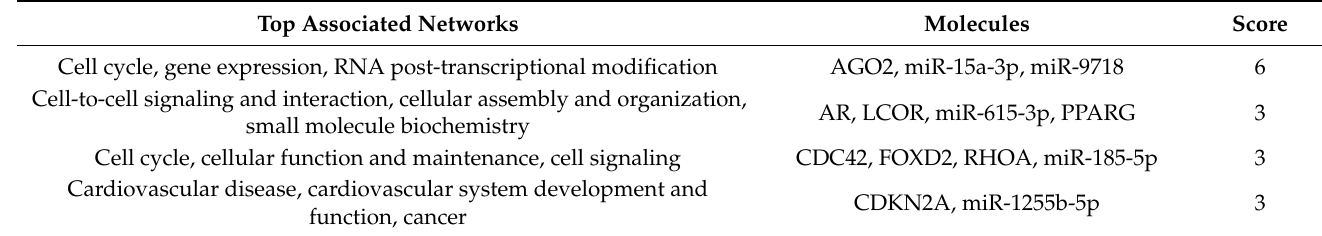
Table 4. IPA core analysis top associated networks and molecules (miRNAs and target genes).